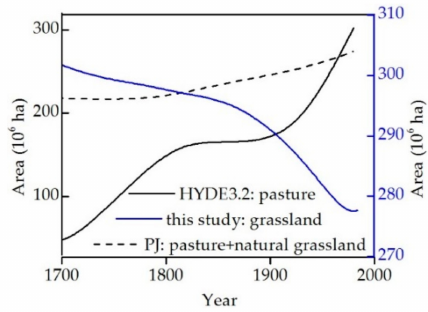
Figure 10. Trends in grassland and pasture area changes across western China over the last 300 years obtained from HYDE 3.2, PJ, and presented in this